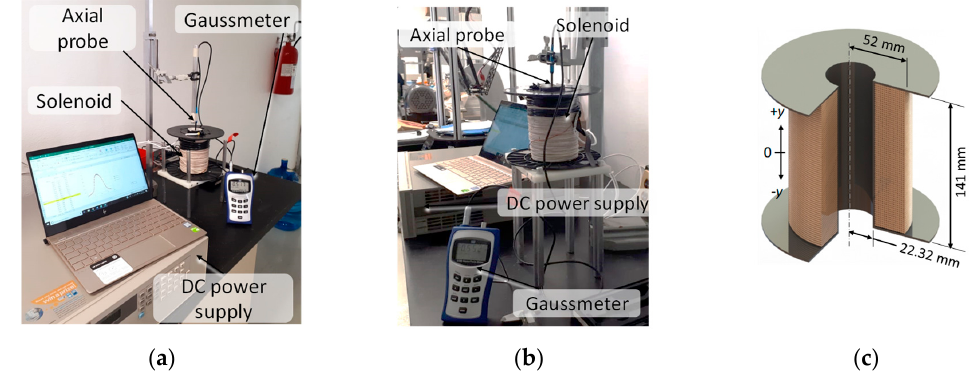
Figure 1. ( a , b ) Test rig for solenoid characterization, a Gaussmeter BELL-5170 with longitudinal probe is used to measure the magnetic flux density along the solenoid longitudinal y axis. Figure ( c ) depicts solenoid geometrical characteristics, this electromagnet has 3600 wire turns and an electrical resistance of 15 Ohms.